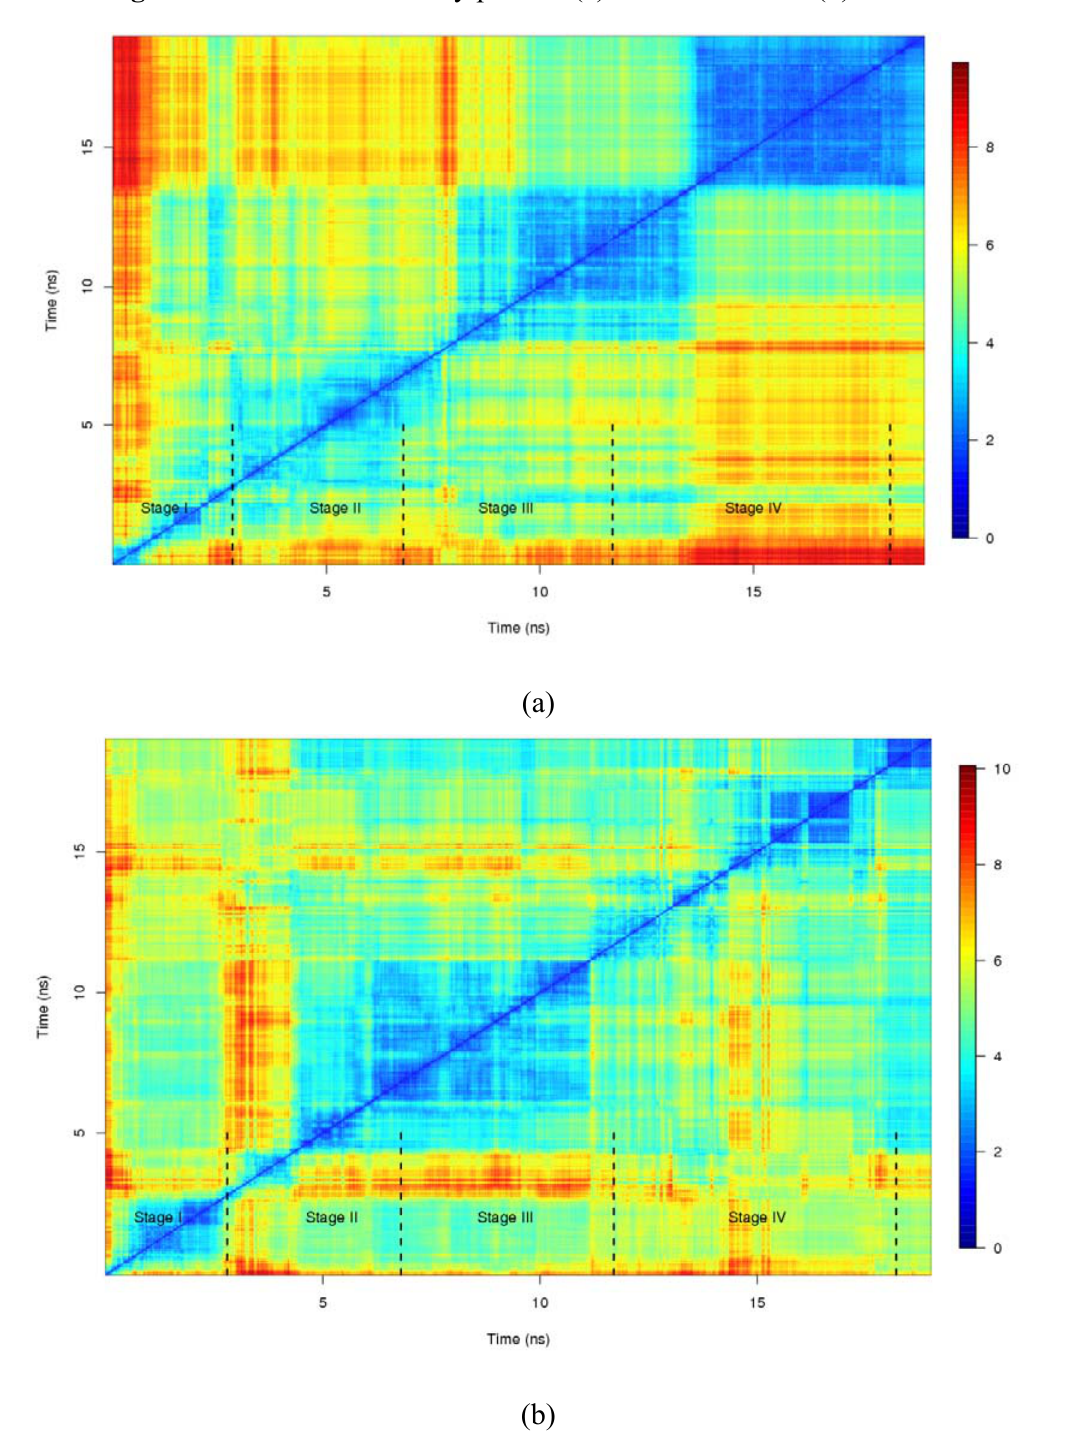
Figure 5. RMSD dissimilarity plot for (a) monomer A and (b) monomer